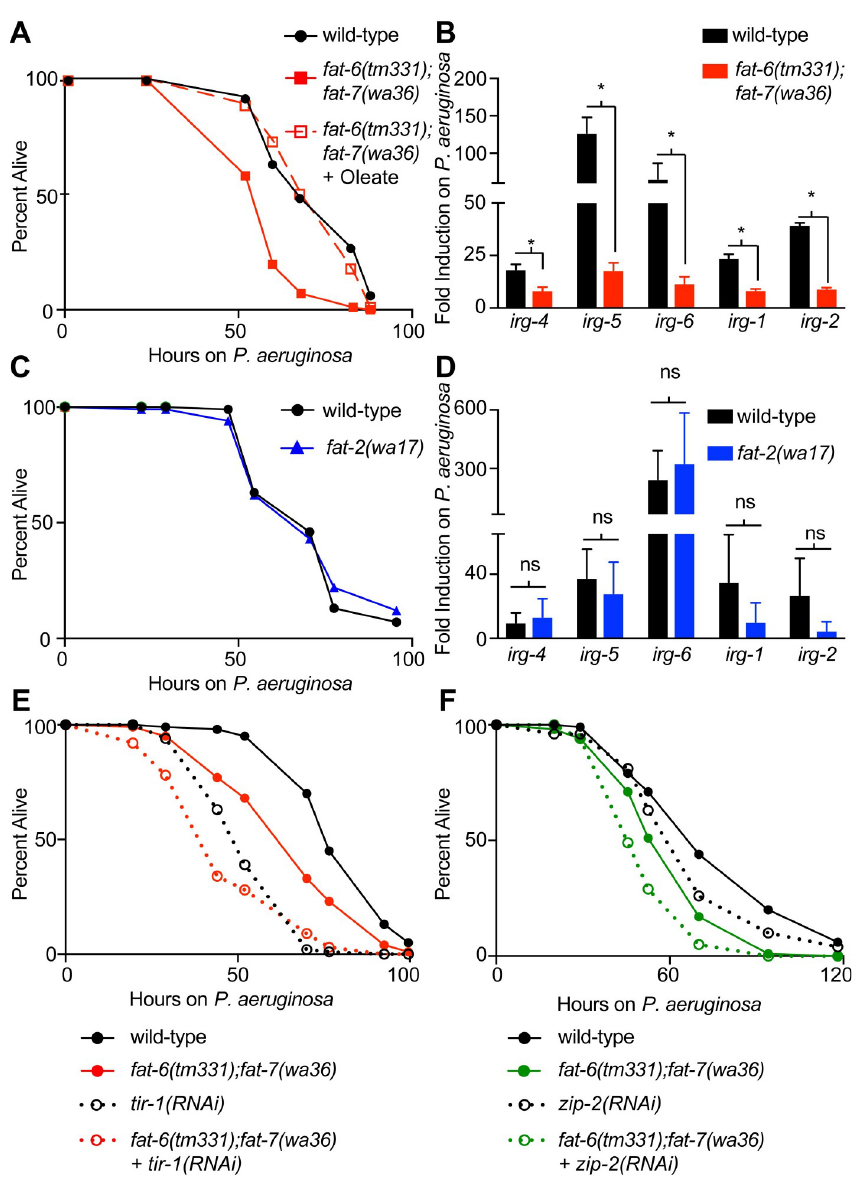
Fig 4. Oleate is required for host resistance to P . aeruginosa infection. A and C. P . aeruginosa pathogenesis assays of wild-type and fat-6(tm331);fat-7(wa36) (A) or fat-2(wa17) (C) animals grown on control media or oleate- supplemented media, as indicated. Animals were transferred at the L4 stage to plates containing P . aeruginosa . Assay plates were not supplemented with oleate. fat-6(tm331);fat-7(wa36) animals are more susceptible to killing by P . aeruginosa (p < 0.01). Oleate supplementation rescues the enhanced susceptibility to pathogen phenotype of the fat-6 Table. Significance was determined using Kaplan-Meier survival curves and log-rank tests. B and D. Expression of the indicated genes measured by qRT-PCR in wild-type, fat-6(tm331);fat-7(wa36) double-mutant, or fat-2(wa17) animals exposed to P . aeruginosa at the L4 stage for 6 hours. Data are the average of three independent replicates, each normalized to a control gene and presented as fold induction in animals of the indicated genetic background infected with P . aeruginosa vs. animals fed the standard bacterial food source ( E . coli OP50). Error bars show standard deviation. Statistical significance was determined using t-tests. � p < 0.05. E and F. P . aeruginosa pathogenesis assays of wild-type and fat-6(tm331);fat-7(wa36) exposed to control RNAi bacteria, tir-1(RNAi) or zip-2(RNAi) bacteria, as indicated. fat-6(tm331);fat-7(wa36)+ tir-1(RNAi) animals are significantly more susceptible than fat-6(tm331);fat-7 (wa36) mutants and tir-1(RNAi) animals (p < 0.05). In addition, fat-6(tm331);fat-7(wa36)+ zip-2(RNAi) animals are significantly more susceptible than fat-6(tm331);fat-7(wa36) mutants and zip-2(RNAi) animals (p < 0.05). Data